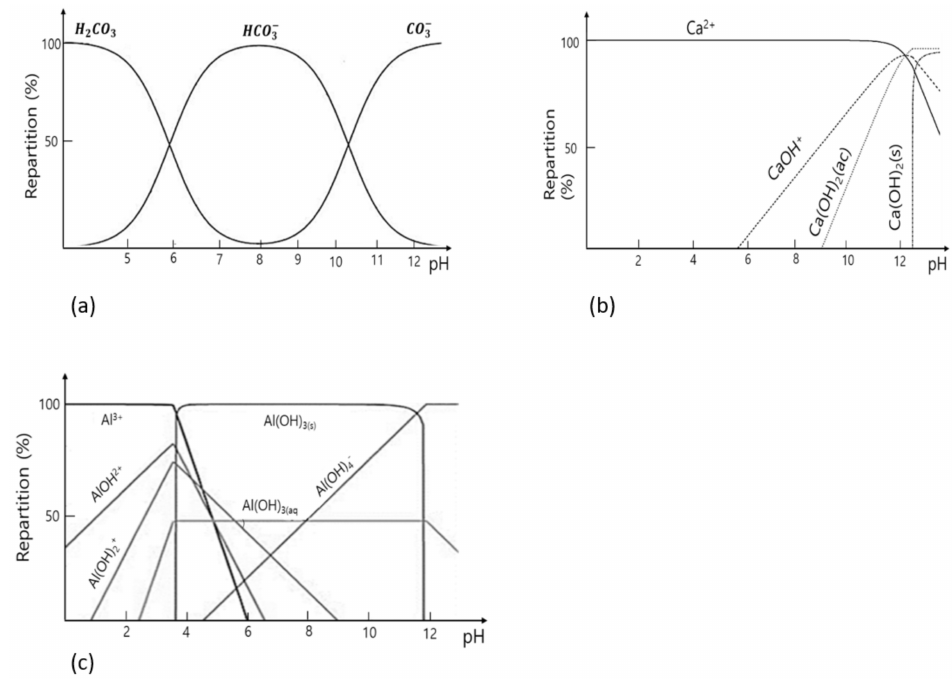
Figure 1. Variation of ( a ) carbonate, ( b ) calcium, and ( c ) aluminum species with pH